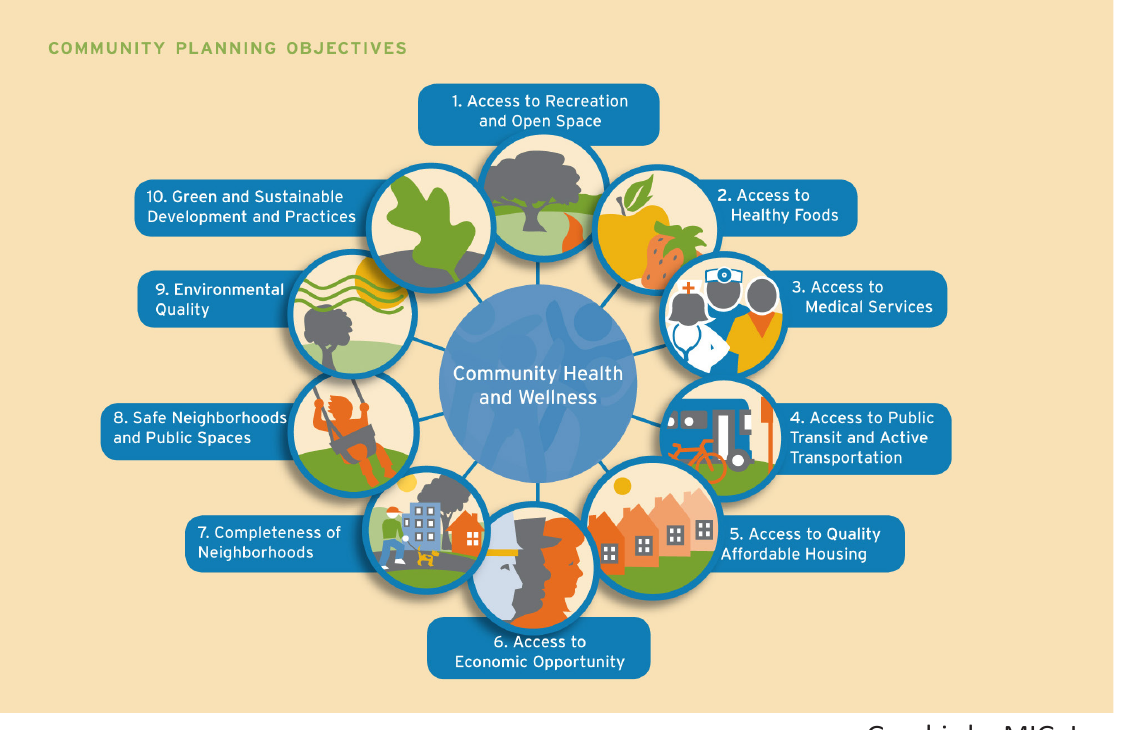
Figure 2. Community Factors Addresses by the Richmond Health and Wellness